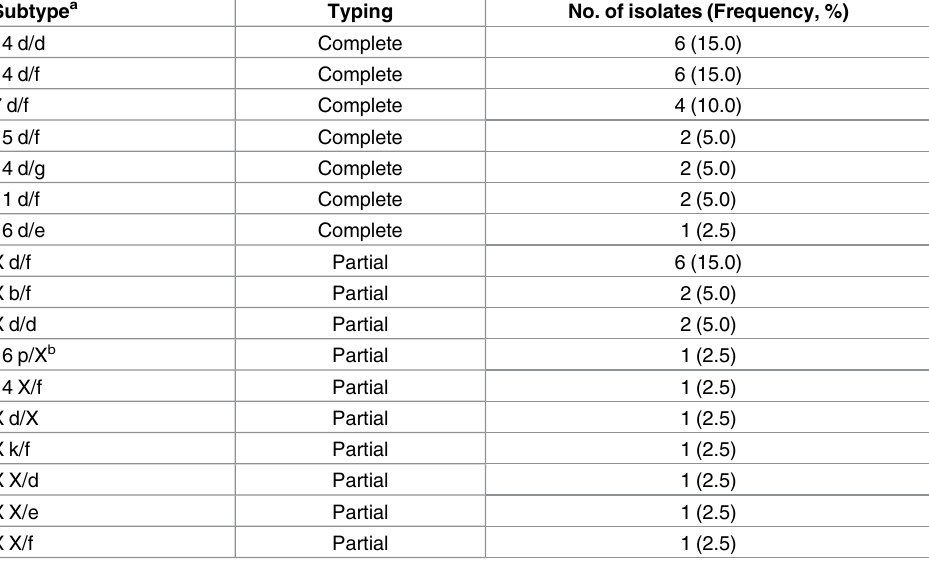
Table 3. ECDCT genotypes detected in 40 samples from syphilis PCR-positive patients from Buenos Aires, Argentina.